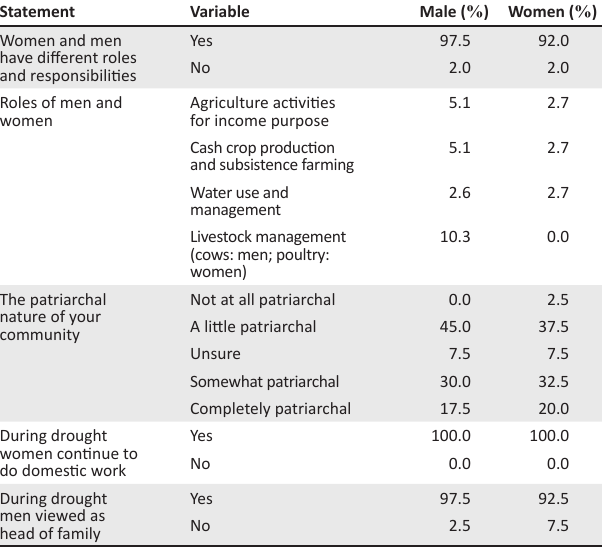
TABLE 1: Gender-differential roles during